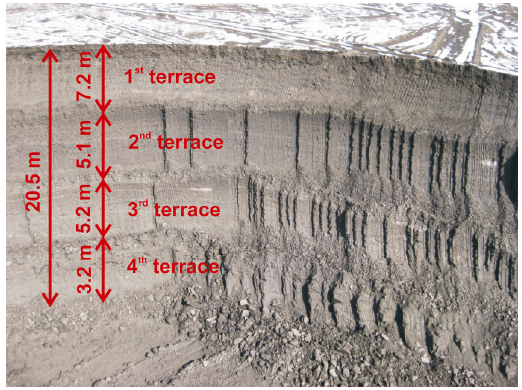
Fig. 4. Mining block during